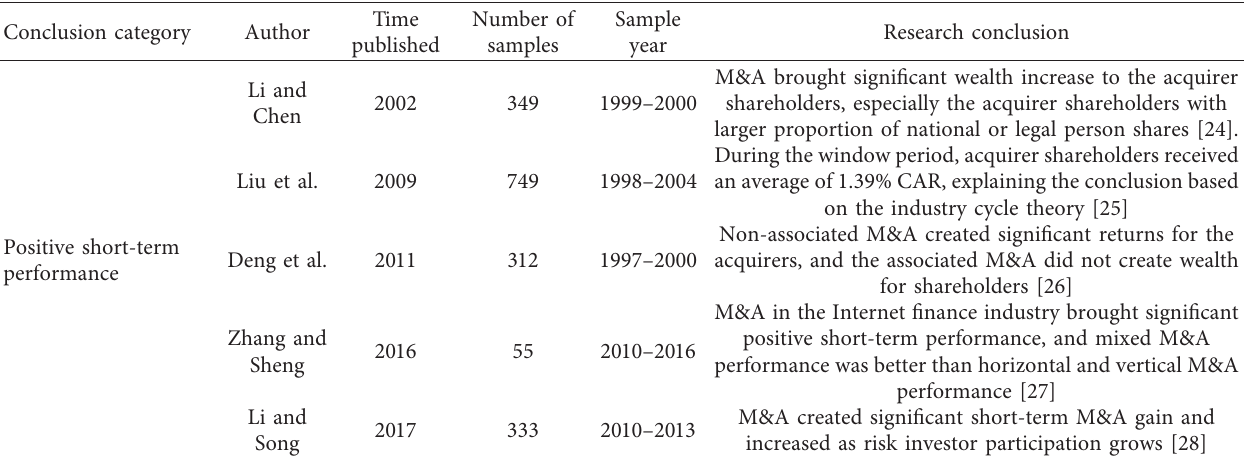
Table 2: Overview of short-term performance research on Chinese